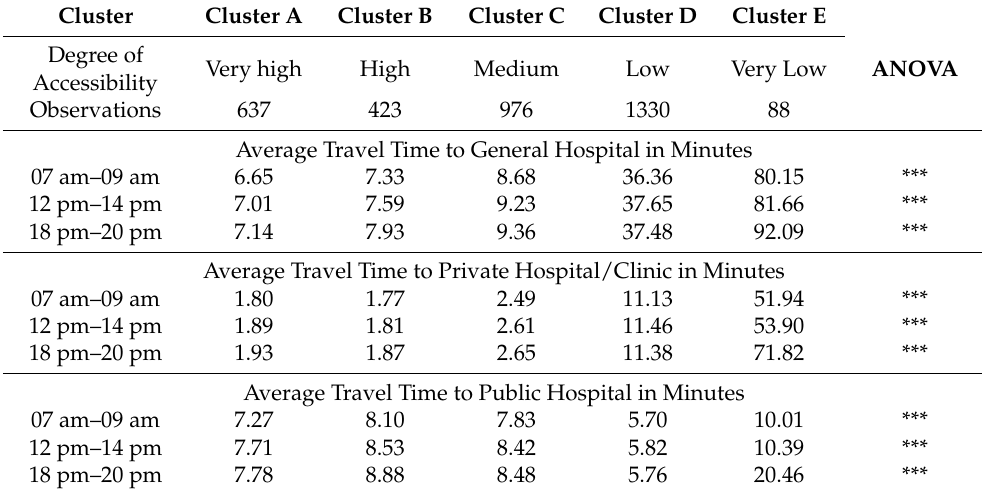
Figure 1. Using the two Gaussian Mixture Models to Find Five Clusters (Cluster A: highly accessible areas; Cluster B: accessible areas; Cluster C: moderate accessible areas; Cluster D: inaccessible areas; Cluster E: highly inaccessible areas). ( a ) Accessibility to healthcare services by car; ( b ) Accessibility to healthcare services by public transportation. Table 4. Average Travel Time to Healthcare Services by Car between 5